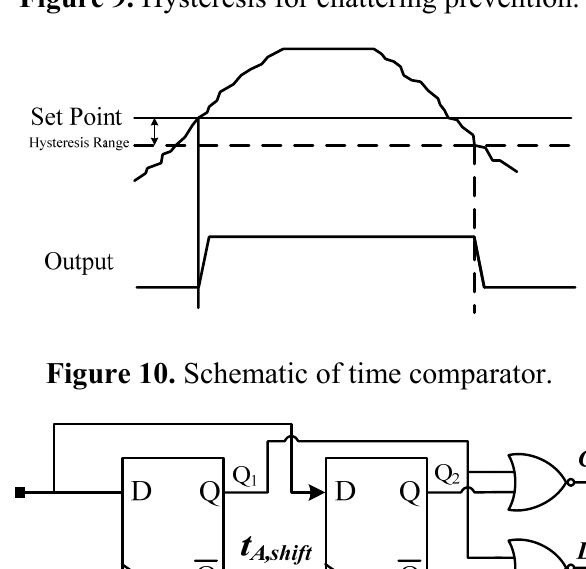
Figure 9. Hysteresis for chattering prevention.